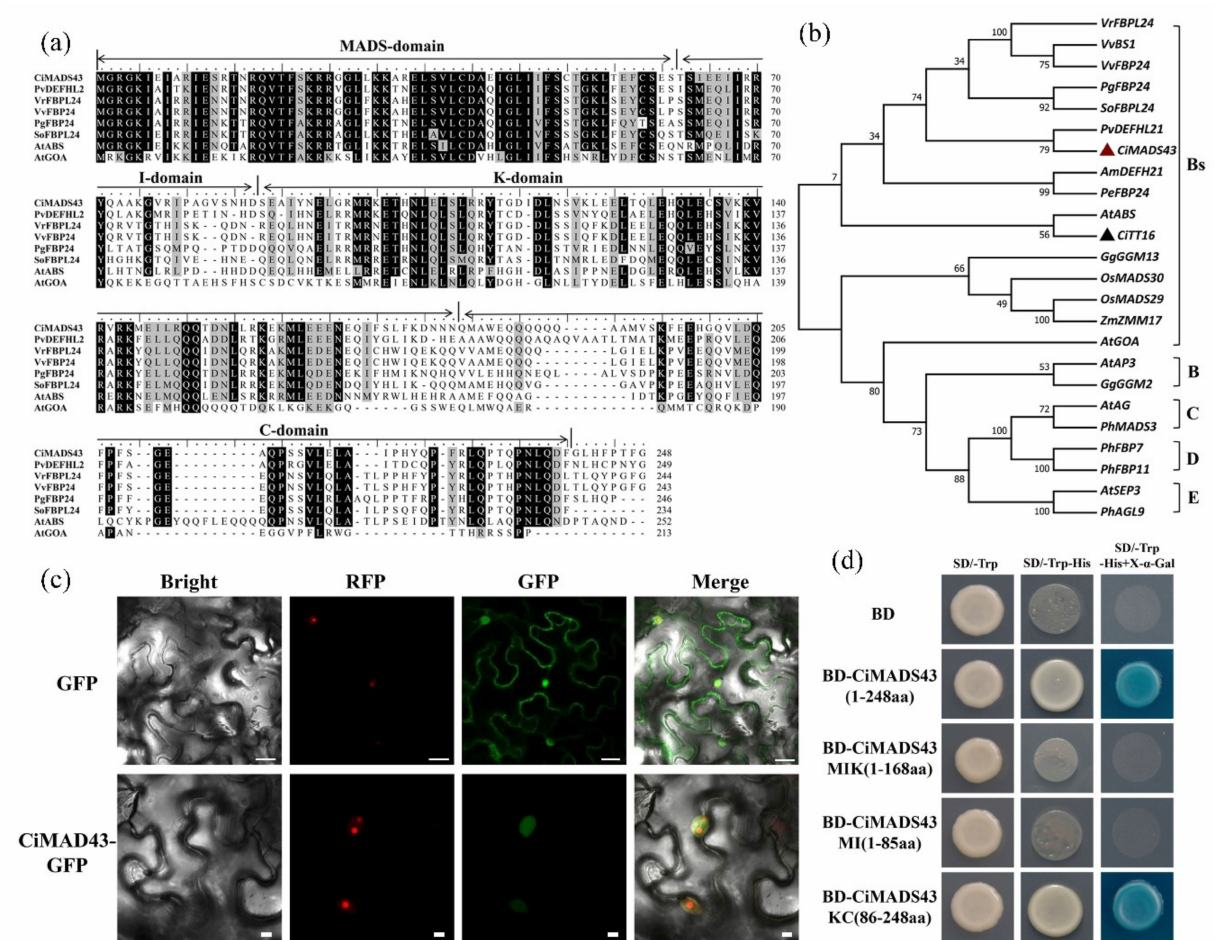
Figure 1. Characterization of the CiMADS43 . ( a ) Multiple sequence alignment of CiMADS43 protein and its homolog proteins. CiMADS43, Citrus sinensis (XP_006468501.1). PvDEFHL21, Pistacia vera (XP_031278613.1). VrFBPL24, Vitis riparia (XP_034698718.1). VvFBP24, Vitis vinifera (XP_010648959.1). PgFBP24, Punica granatum (XP_031400121.1). SoFBPL24, Syzy- gium oleosum (XP_030467505.1). AtABS, Arabidopsis thaliana (NP_001330404.1). AtGOA, Arabidopsis thaliana (NP_174399.2). ( b ) Phylogenetic analysis of MADS-box proteins from citrus and other plants. The gene ID of all MADS-box proteins were listed in Table S1. The red triangle indicates the citrus GORDITA (GOA)-like Bsister gene and the black triangle indicates the citrus ABS-like Bsister gene. ( c ) Subcellular localization of CiMADS43 in tobacco leaves. Green fluorescent protein (GFP) fused to the C -terminal region of CiMADS43 , and the fusion protein was driven by 35S promoter. Red fluorescent protein (RFP) label was used as a nuclear marker driven by 35S promoter, and 35S::GFP was used as positive control. Scale bar = 5 0 µ m. ( d ) Analysis of CiMADS43 transcription activation. CiMADS43 represents a full-length protein, and CiMADS43MIK was a truncated protein that the C -terminal region was removed, containing M domain, I domain and K domain. CiMADS43MI indicates the N -terminal region of CiMADS43 protein including M domain and I domain, while CiMADS43KC indicates the C -terminus of CiMADS43 protein including K domain and C